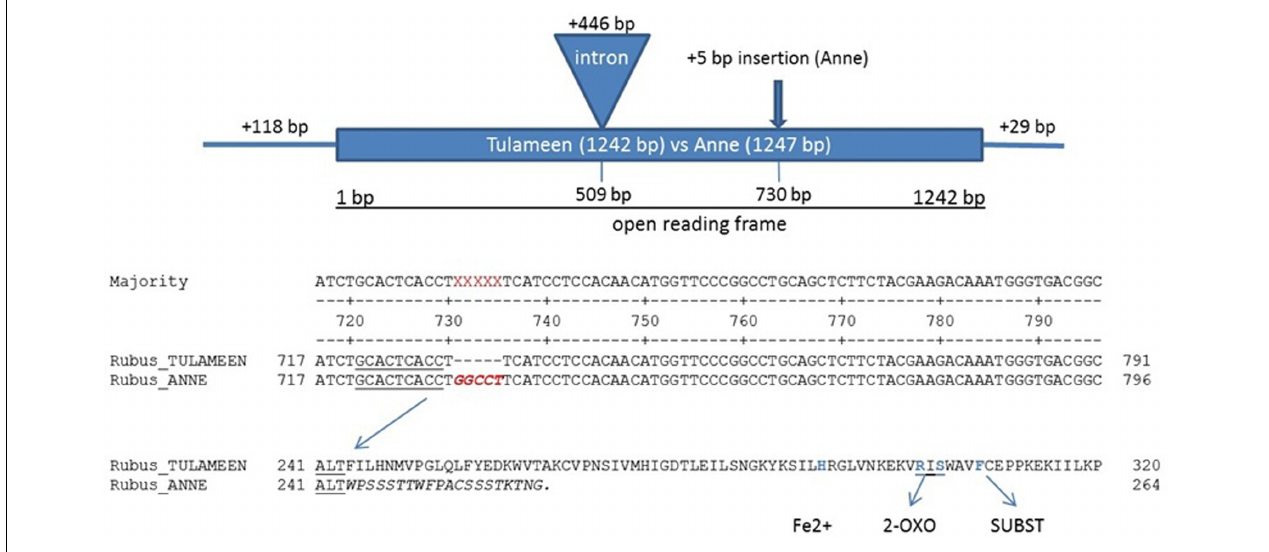
FIGURE 2 | Analyses of anthocyanidin synthase alleles in cv. “Tulameen” and “Anne”. Comparison indicate a 5 bp insertion (ans + 5 ) in the second exon at position 730 of “Anne” allele (ans) causing a frameshift and thus leading to a truncated protein in the yellow variety, missing conserved regions for substrate-, co-substrate, and iron binding sites. The Ans fragment from “Anne” and “Tulameen” includes the entire coding region with one 446 bp intron at position 509, and 118 bp of the 5 (cid:48) UTR and 29 bp of the 3 (cid:48) UTR. TABLE 1 | Copy number of Ans gene in Rubus genome. Rosaceae members Mass of haploid Average Ans Ratio w.r.t Ratio w.r.t. genome (g) gene copies ± SD Fragaria vesca Fragaria × ananassa reference reference Fragaria × ananassa 2,6e-13 302714 ± 52332 – 4 3,3e-13 76850 ± 5971 – 7,6e-13 87050 ± 16858 7,6e-13 81971 ± 655 7,6e-13 64138 ±